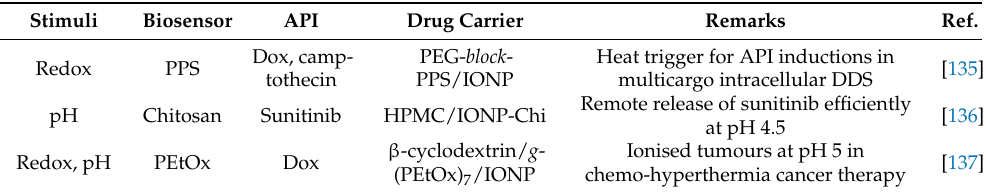
Table 5. Magnetothermal triggers with added redox and pH stimuli in drug carriers with biosensors, with remarks listed.